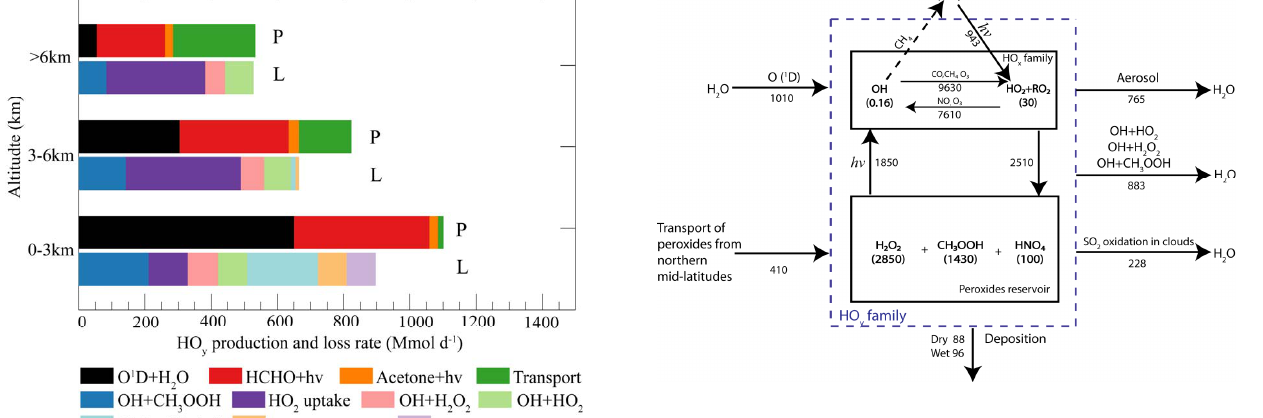
Figure 7 Schematic diagram of HO x -HO y chemistry in Arctic spring as constructed from the GEOS-Chem model simulation of the ARCTAS observations. Values are tropospheric column averages for April 2008 over the Arctic cap (60-90N). Masses of chemicals within the domain (in parentheses) are in units of Mmol and rates are in units of Mmol d -1 . The dashed line for HCHO production indicates that it is not a HO y sink.